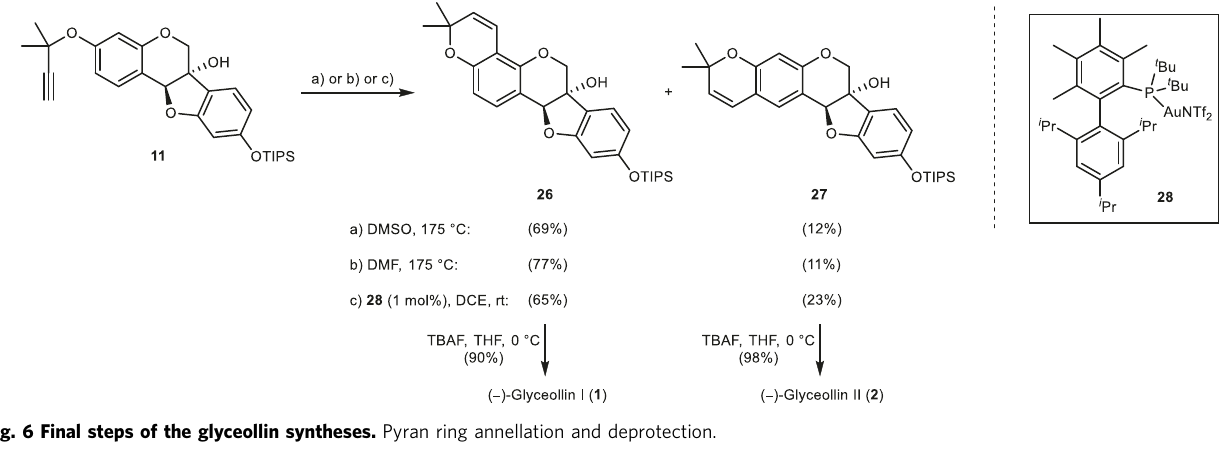
Fig. 6 Final steps of the glyceollin syntheses. Pyran ring annellation and deprotection.